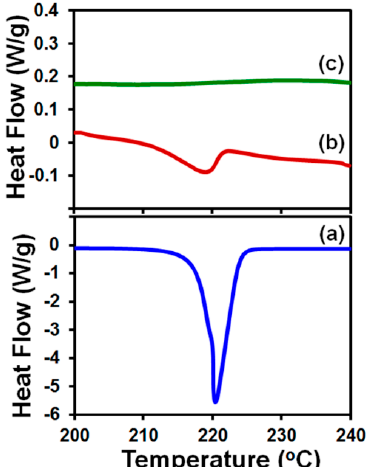
Figure 5. DSC curves of specimens overlaid on the temperature range 200–240 °C: ( a ) as-received griseofulvin powder (0.5 mg); ( b ) 3.5-mg porous HPMC film with five printed 0.5-µL droplets of 2.5% HPMC-griseofulvin-suspension (calculated griseofulvin content 0.45 mg); ( c ) porous HPMC film (3 mg) without the suspension.